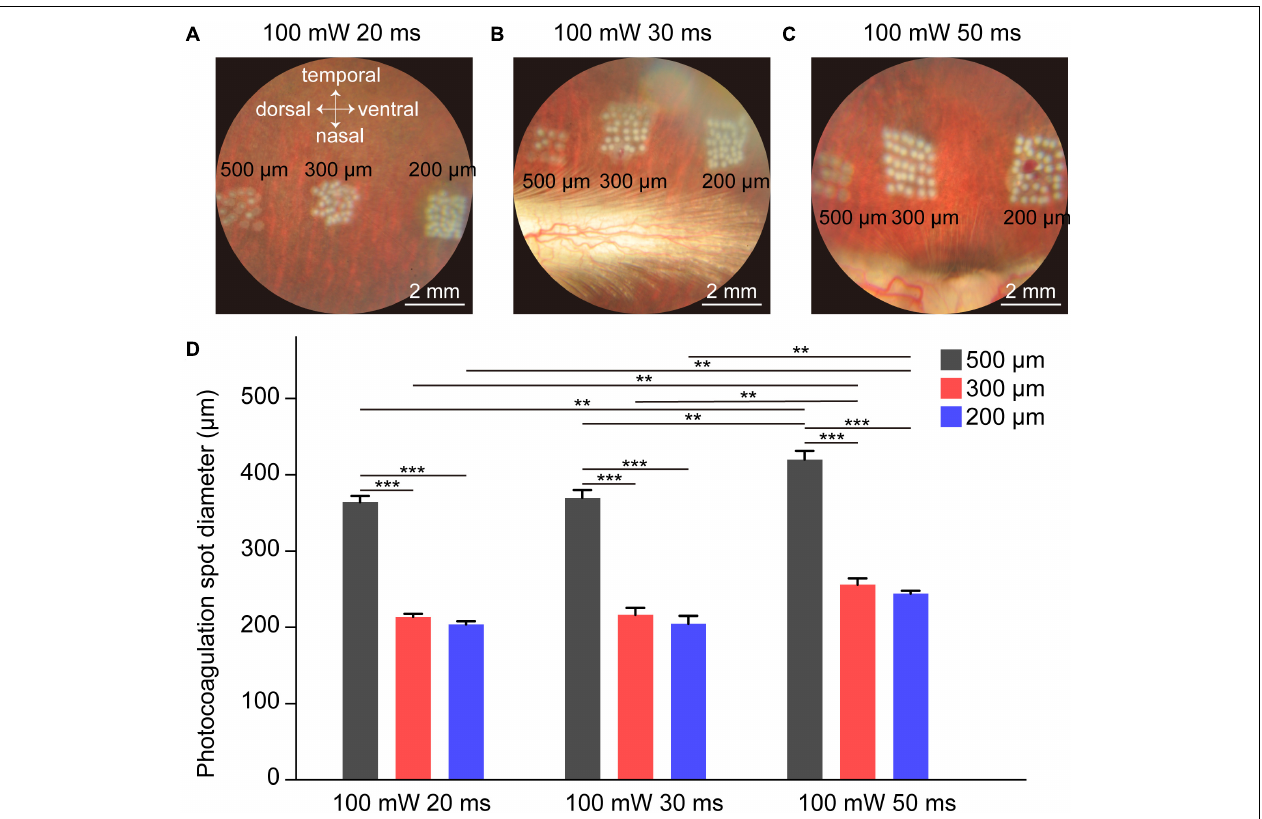
FIGURE 1 | Fundus images of rabbit retina under different photocoagulation conditions 1 h after surgery. (A–C) Fundus images of retina after photocoagulation of 200, 300, and 500 µ m laser spot size produced by 100 mW laser power and 20 (A) , 30 (B) , or 50 ms (C) pulse duration. Scale bar = 2 mm. (D) Lesion diameter on retina by photocoagulation with 200, 300, or 500 µ m laser spot size produced by 100 mW laser power and 20, 30, or 50 ms duration (number of spots: n 20 ms / 500 µ m = 9, n 20 ms / 300 µ m = 15, n 20 ms / 200 µ m = 15, n 30 ms / 500 µ m = 10, n 30 ms / 300 µ m = 15, n 30 ms / 200 µ m = 15, n 50 ms / 500 µ m = 9, n 50 ms / 300 µ m = 15, n 50 ms / 200 µ m = 14, Each set of spots comes from one retina). Data were presented as Mean ± SEM. ** P < 0.01, *** P <